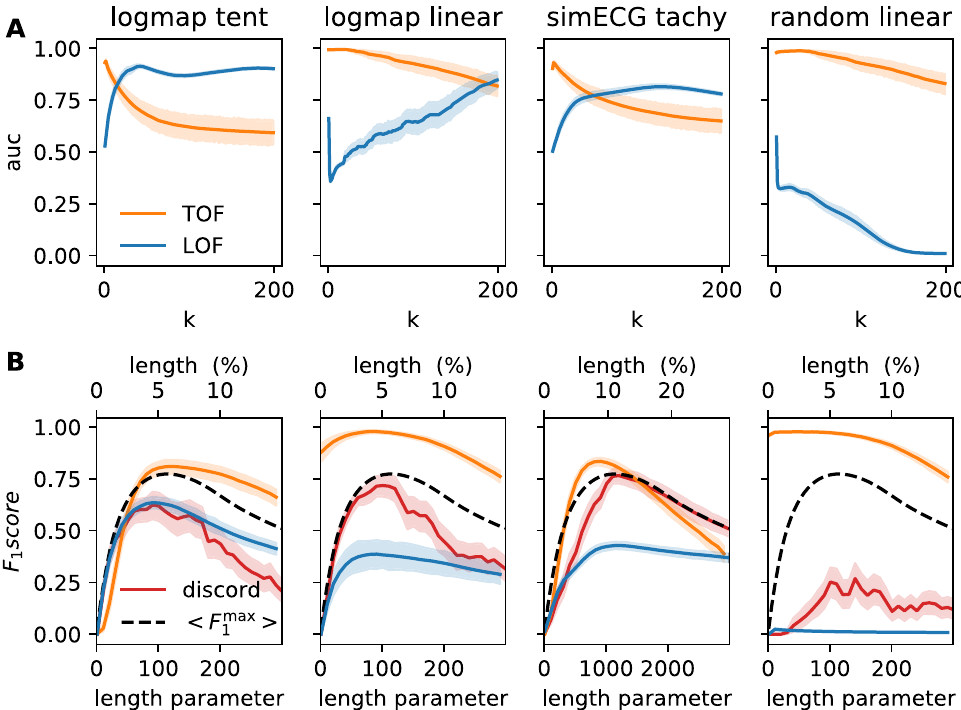
Figure 3. Performance evaluation of TOF, LOF, and Keogh’s discord detection algorithms on four simulated datasets. ( A ) Mean Receiver Observer Characteristic Area Under Curve (ROC AUC) score and SD for TOF (orange) and LOF (blue) are shown as a function of neighborhood size ( k ). TOF showed the best results for small neighborhoods. In contrast, LOF showed better results for larger neighborhoods in the case of the logistic map and ECG datasets but did not reach reasonable performance on random walk with linear outliers. ( B ) Mean F 1 score for TOF (orange), LOF (blue), and Keogh’s discord detection (red) algorithms as a function of the expected anomaly length (for TOF) given in either data percentage (for LOF) or window length parameter (for discord). Black dashed lines show the theoretical maximum of the mean F 1 score for algorithms with prefixed detection numbers or lengths (LOF and discord), but this upper limit does apply for TOF. The F 1 score of TOF was very high for the linear anomalies and slightly lower for logistic map—tent map anomaly and ECG datasets, but it was higher than the F 1 score of the two other methods and their theoretical limits in all cases. Note, that the only comparable performance was shown by discord detection on ECG anomaly, while neither algorithms based on discord nor LOF were able to detect the linear anomaly on random background.